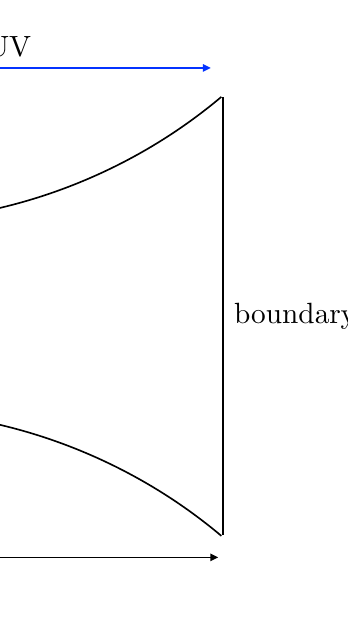
r 0 ) (cid:15)=b and an IR (cid:0) (cid:29)